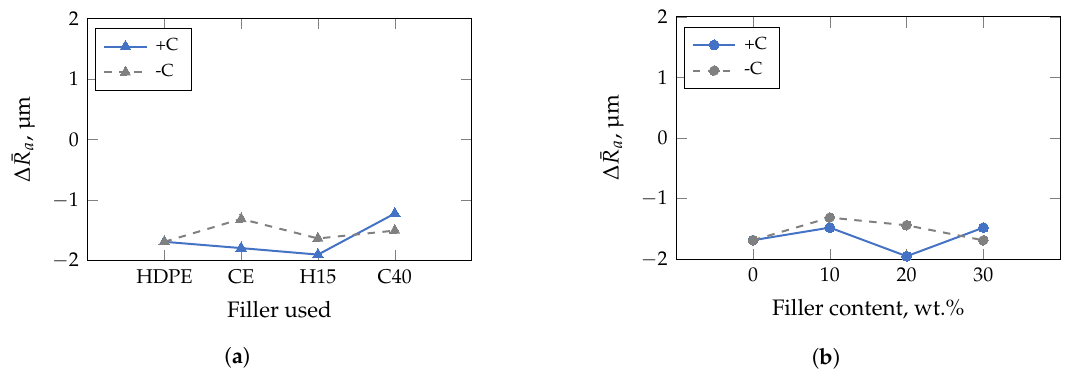
Figure 11. Results of multivariate analysis of variance performed with a confidence interval of 95% for insert with high roughness. Compatibilizer dependence is marked with +C (with) and − C (without). Although the used filler as well as the filler and compatibilizer content are statistically significant, no clear trend is discernible between ( a ) the filler CalPlex Extra (CE), Plustalc H15 (H15), CalPlex 40 (C40), and ( b ) the filler content.